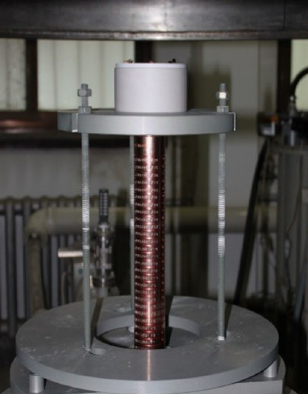
FIG. 1. Main cell stack for diffusion bonding in Tsinghua